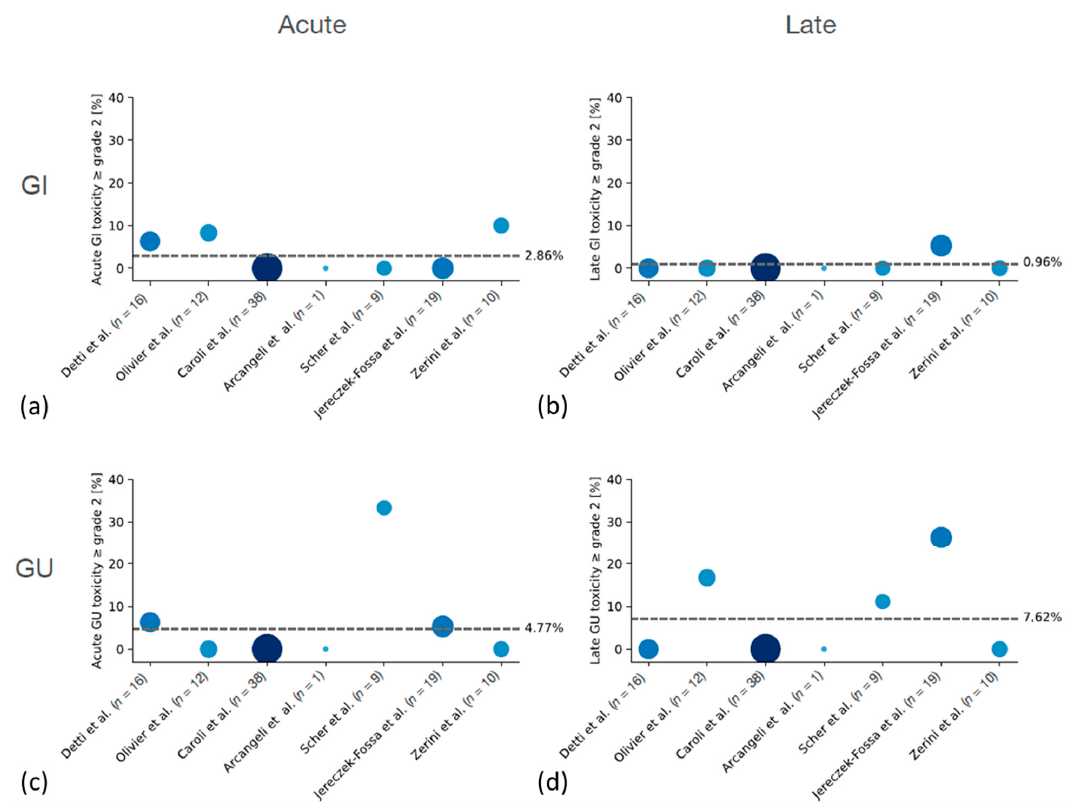
Figure 2. ( a – d ) Summary of ≥ G2 acute and late toxicities in patients without prior radiotherapy. Area and color of the dots indicate the size of the respective study.